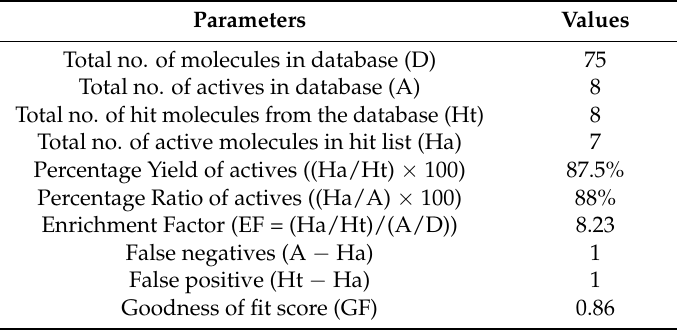
Table 3. Decoy set validation. The decoy set validation of Hypo1 obtained highest goodness of fit (GF) score (0.86) and suggested its suitability for virtual screening.